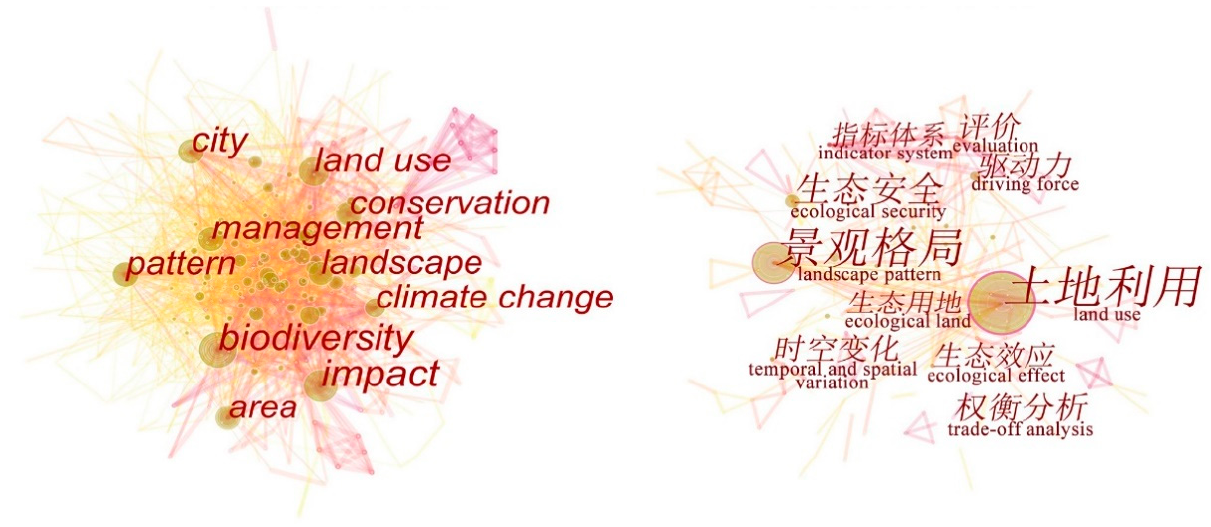
Figure 1. Co-occurrence of international keywords ( left ) and domestic keywords ( right ).